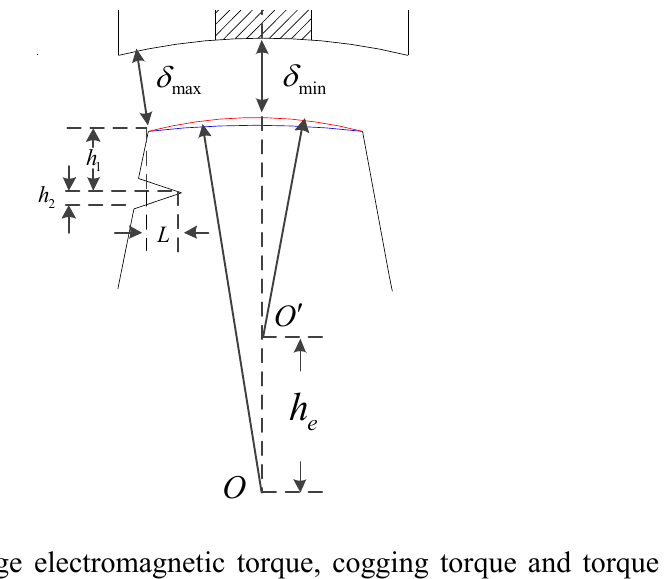
Figure 13. The model of rotor with the combination of eccentric and notched